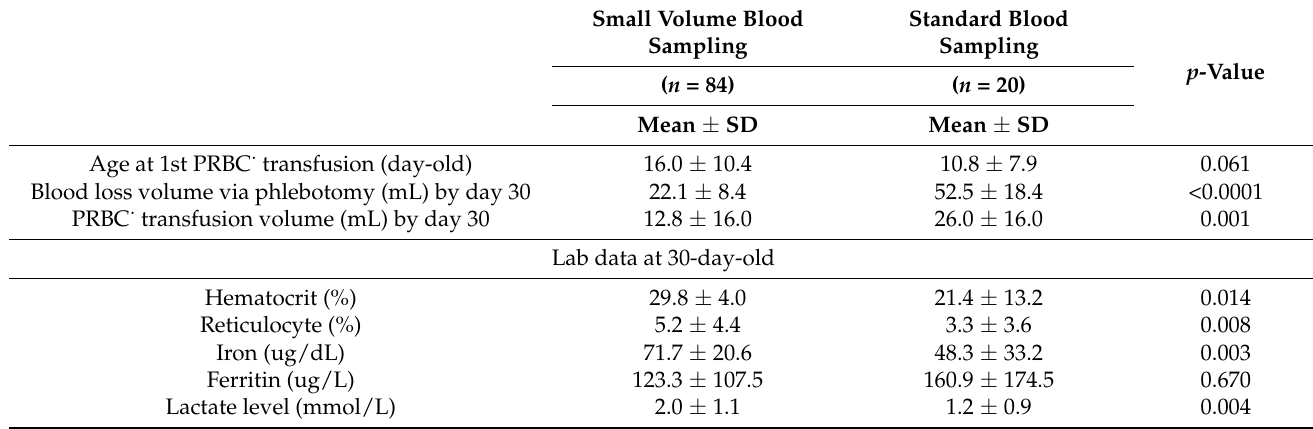
Table 2. Physiology measurements at day 30 in both groups.